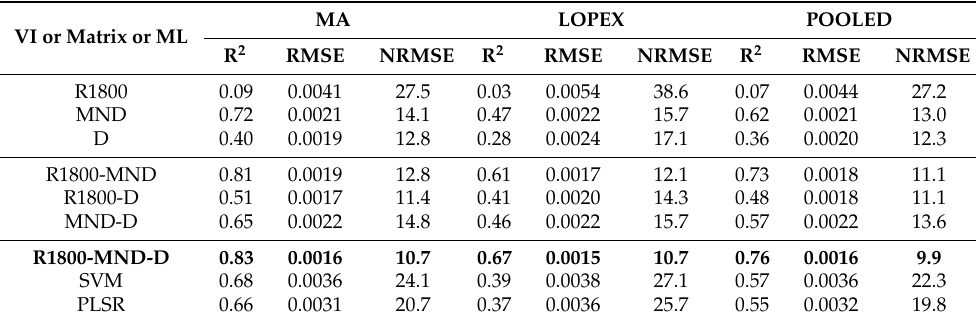
Table 7. Corresponding to R1800-MND-D matrix, the coefficient of determination (R 2 ), root mean square error (RMSE, in g/cm 2 ), and normalized RMSE (NRMSE, %) of the estimated LMA from experimental datasets using 3D matrix, corresponding 2D matrices, single VIs, support vector machine (SVM), and partial least-squares regression (PLSR) (the optimal results are indicated in